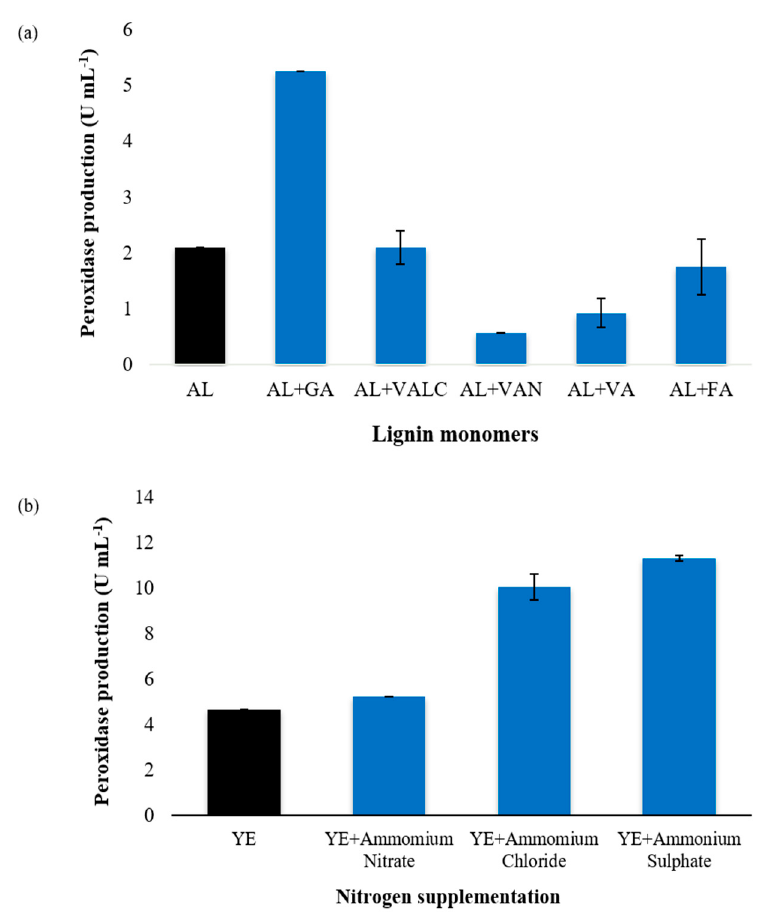
Figure 2. E ff ect of lignin monomers and nitrogen supplementations on exoperoxidase production by Ensifer adhaerens NWODO-2. ( a ) E ff ect of lignin monomers on exoperoxidase production. AL: alkali lignin (Control), GA: guaiacol, VALC: veratryl alcohol, VAN: vanillin, VA: vanillic acid, FA: ferulic acid. Analysis of variance: F = 1023, p value = p < 0.0001, p value summary = *** (highly significant), R squared = 0.9988. ( b ) E ff ect of nitrogen supplementations on exoperoxidase production. YE: Yeast Extract (Control). Analysis of variance: F = 17940, p value = p < 0.0001, p value summary = *** (highly significant), R squared = 0.9999.